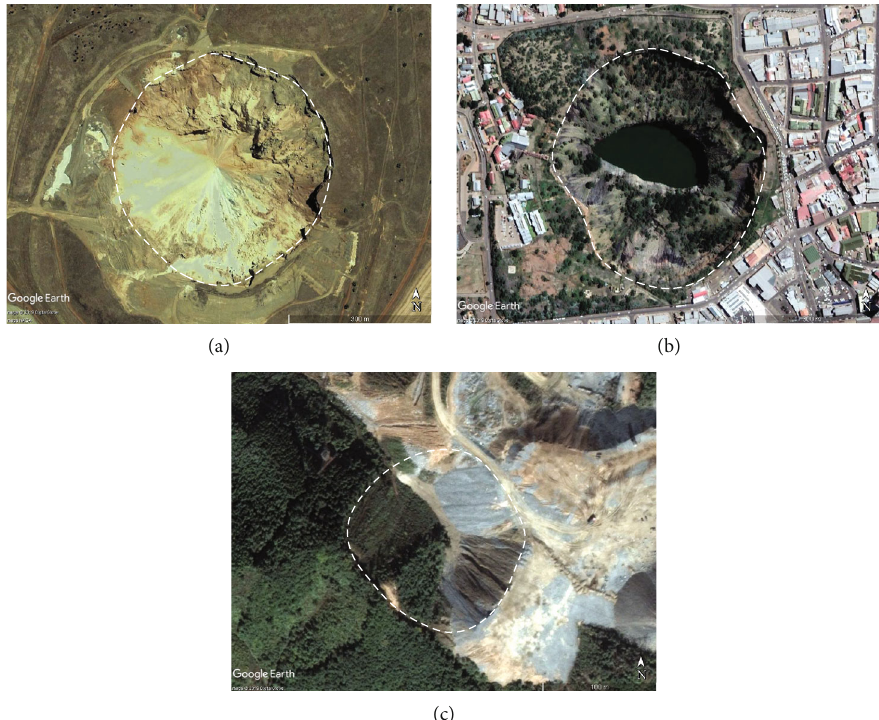
Figure 1: Circular surface subsidence observed visually in Google Earth satellite images: (a) Northparkes copper-gold mine, Australia; (b) Kimberley diamond mine, South Africa; (c) Xiaowanggou iron mine, China.